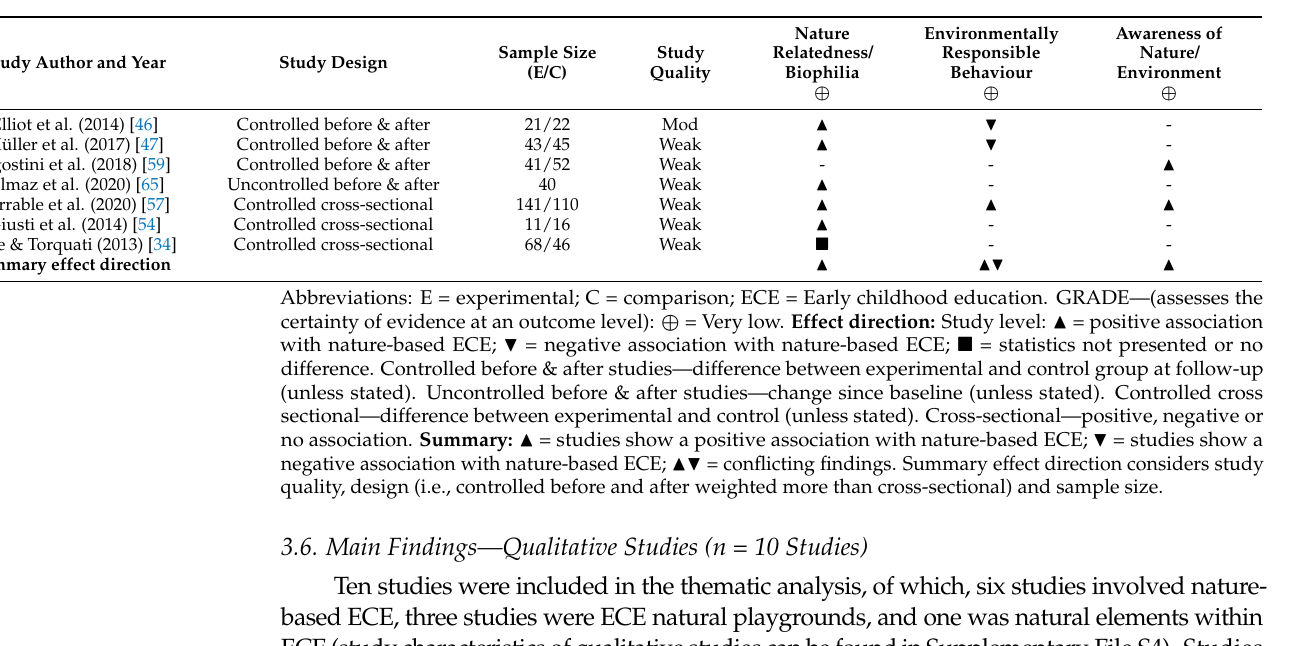
Table 5. Effect direction plot for nature-based ECE vs. traditional ECE on nature